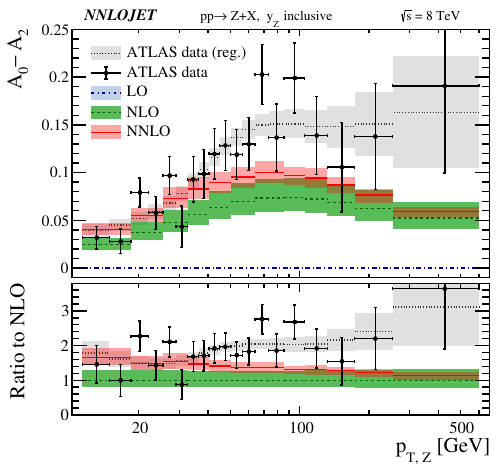
Figure 10 . The p T ; Z distribution for the di(cid:11)erence of angular coe(cid:14)cients ( A 0 (cid:0) A 2 ) in pp collisions p at s = 8 TeV. The ATLAS data (black points) are compared to the LO (blue (cid:12)ll), NLO (green (cid:12)ll), and NNLO (red (cid:12)ll) theoretical predictions. In addition, the regularised ATLAS data is also included (grey (cid:12)ll). In the lower panel, each distribution is shown normalised with respect to the central NLO prediction.